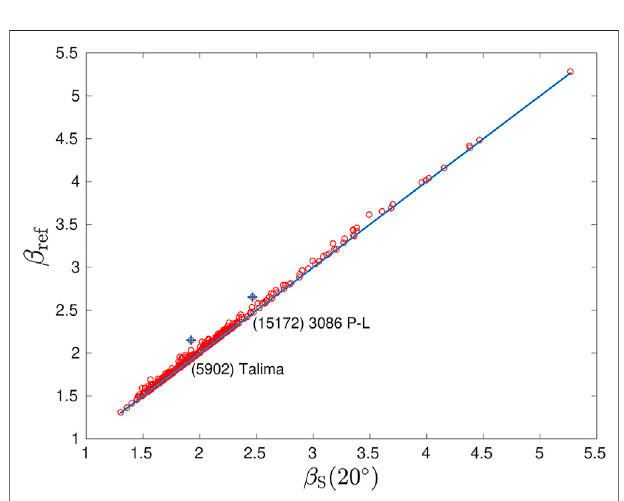
FIGURE 4 | Comparison of the derived β S (20 ° ) and β ref values using 358 asteroids. The blue line represents perfect correlation. Two noticeable outliers (5902) Talima and (15172) 3086 P-L are marked with blue